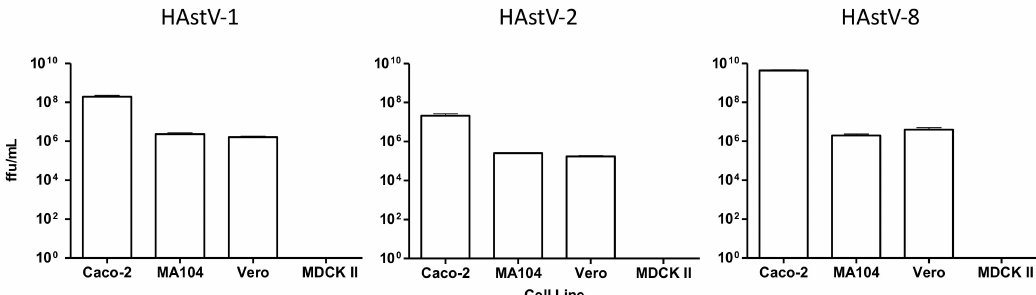
Figure 1. Permissiveness of cell lines to HAstV infection. Caco-2, MA104, Vero and MDCKII cells were infected with serial two-fold dilutions of HAstV-1, HAstV-2 or HAstV-8 and the infectious titer was determined by an immunoperoxidase assay (see Material and Methods). The arithmetic means and SEM for three independent experiments performed in duplicate are